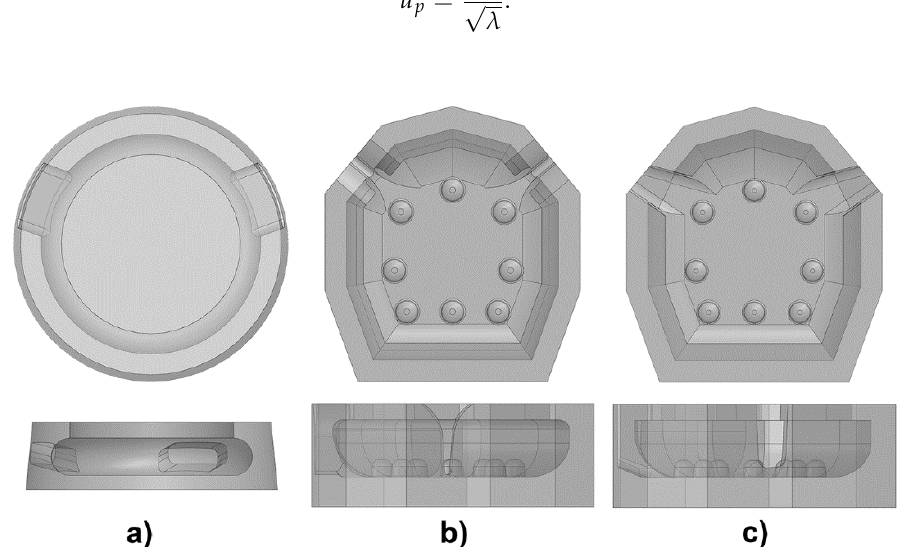
Figure 1. Turbulence inhibitors tested in this work: ( a ) TI1; ( b ) TI2; ( c ) TI3.